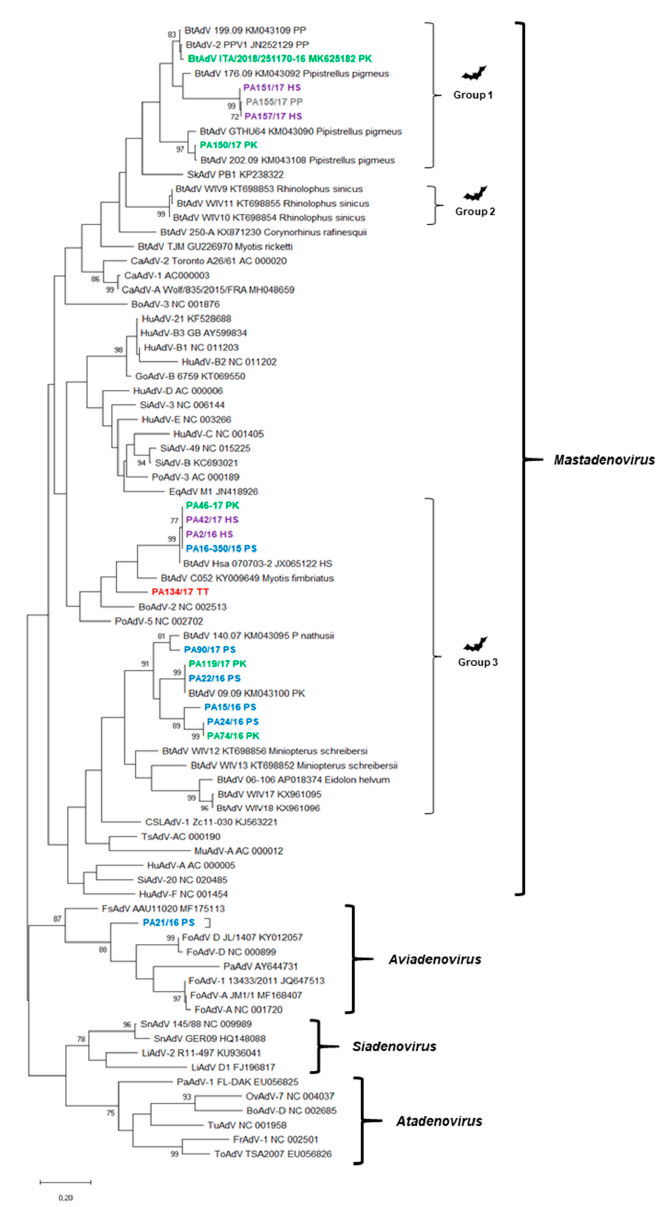
Figure 4. Phylogenetic tree based on the partial polymerase-coding region (233 nt positions) of adenoviruses. GenBank accession numbers are provided for reference strains. The tree was generated using the maximum-likelihood method with the Jukes–Cantor method by bootstrapping over 1000 replicates. Bootstrap values > 70% are shown. Scale bar indicates nt substitutions per site. Blackarrows indicates the strains sequenced in this study. PS, Pipistrellus spp. (blue color); PP, Pipistrellus pipistrellus (grey color); PK, Pipistrellus kuhlii (green color); HS, Hypsugo savii (purple color); TT, Tadarida teniotis (red color). BtAdV, bat adenovirus, SkAdV, skunk adenovirus, EqAdV,